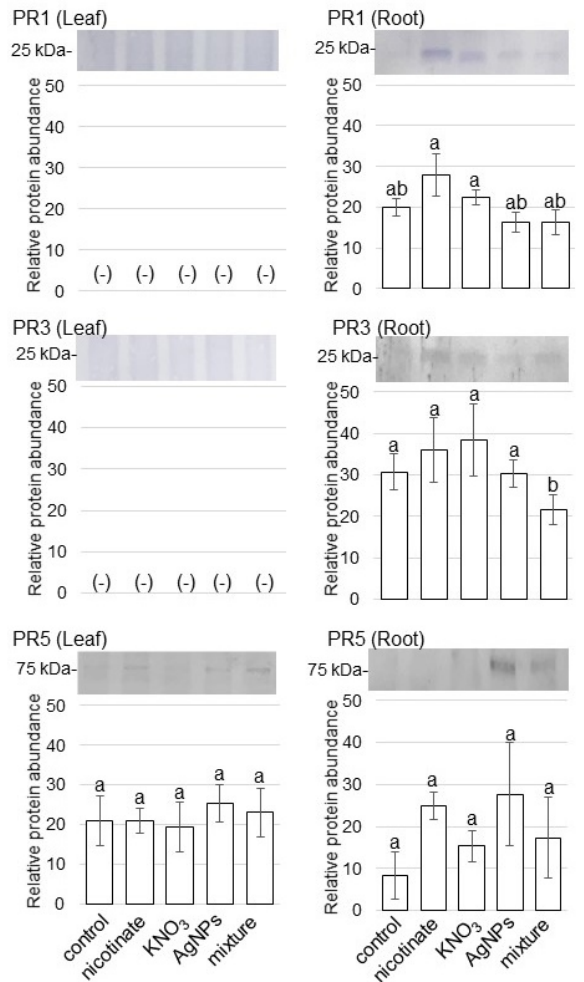
Figure 5. Accumulation of PR proteins in wheat treated with AgNPs/nicotinate/KNO 3 . Three-day- old wheat seedlings were treated with and without 8 mM nicotinate, 0.1 mM KNO 3 , 5 ppm AgNPs, and 5 ppm AgNPs/8 mM nicotinate/0.1 mM KNO 3 (mixture) for 3 days. Proteins (10 µg) extracted from leaves and roots were separated on SDS-PAGE and immunoblot analyses were performed with anti-PR1, PR3, and PR5 antibodies. The integrated densities of bands were calculated using Image J software. The data are presented as mean ± SD from 3 independent biological replicates (Figures S4 and S5). Statistical analysis is the same as Figure 2.